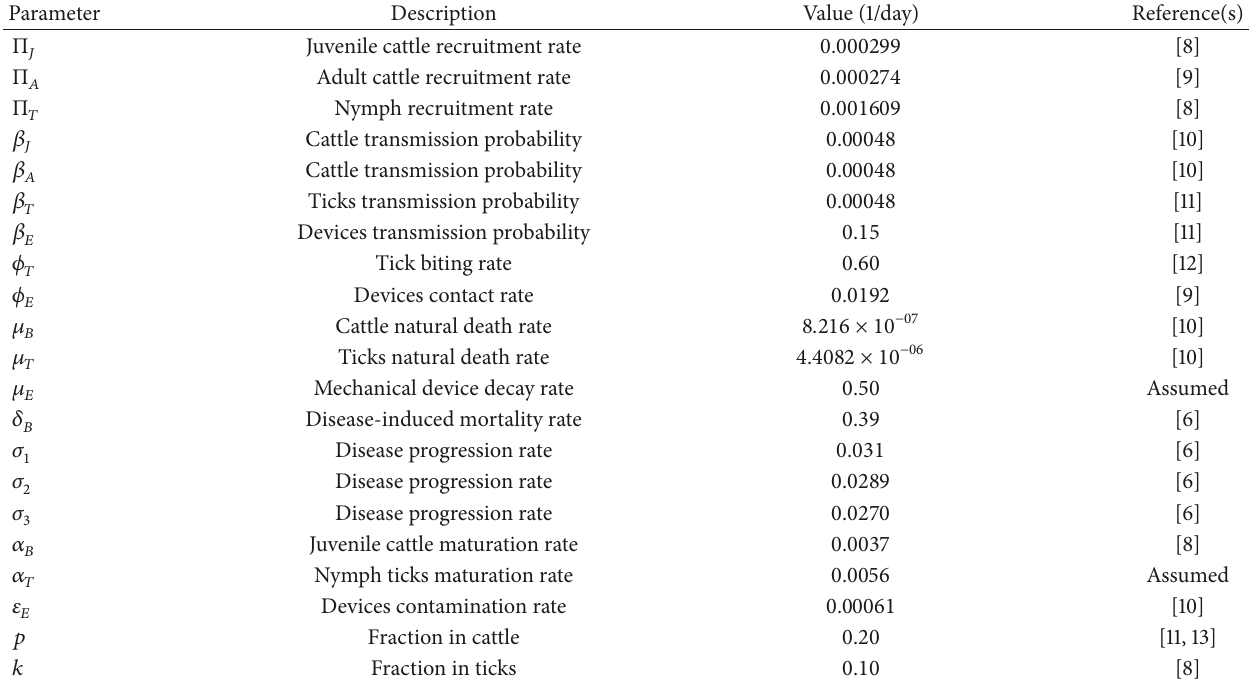
Table 1: Parameter values for the bovine anaplasmosis model